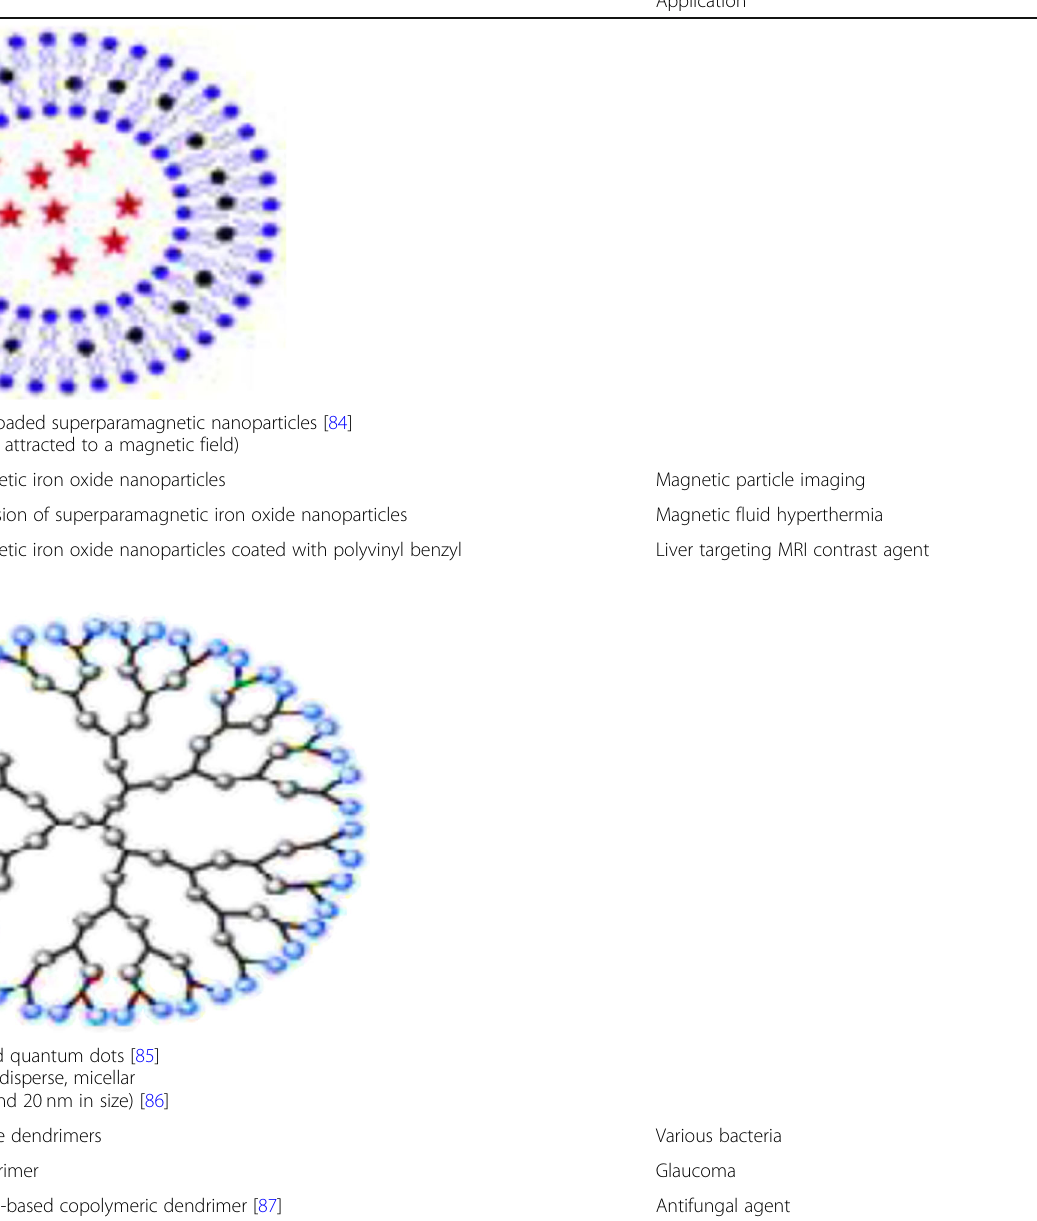
Table 2 Application of different types of nanoparticles (Continued) Nanoparticles types